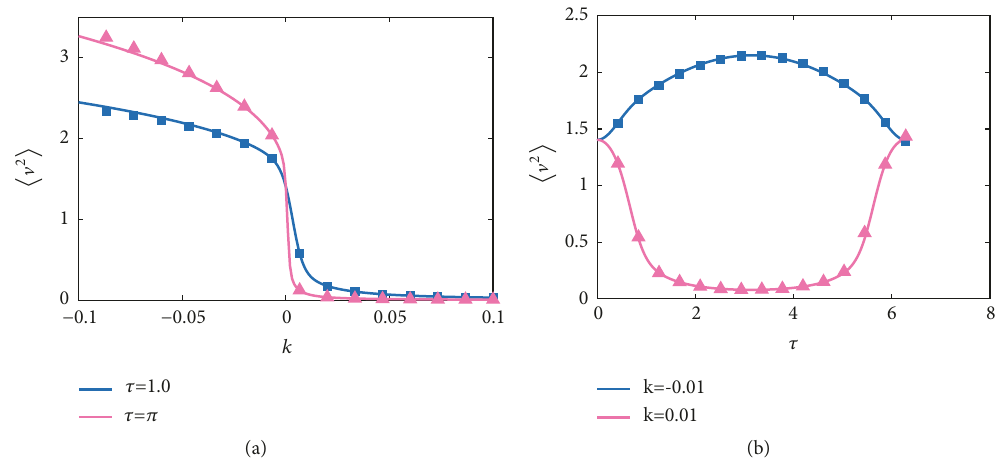
Figure 10: (a) The dependence of the mean square electric voltage ⟨ V 2 ⟩ on 𝑘 . (b) The dependence of the mean square electric voltage ⟨ V 2 ⟩ on 𝜏 . Solid lines are the analytical results; symbols result from numerical simulations.